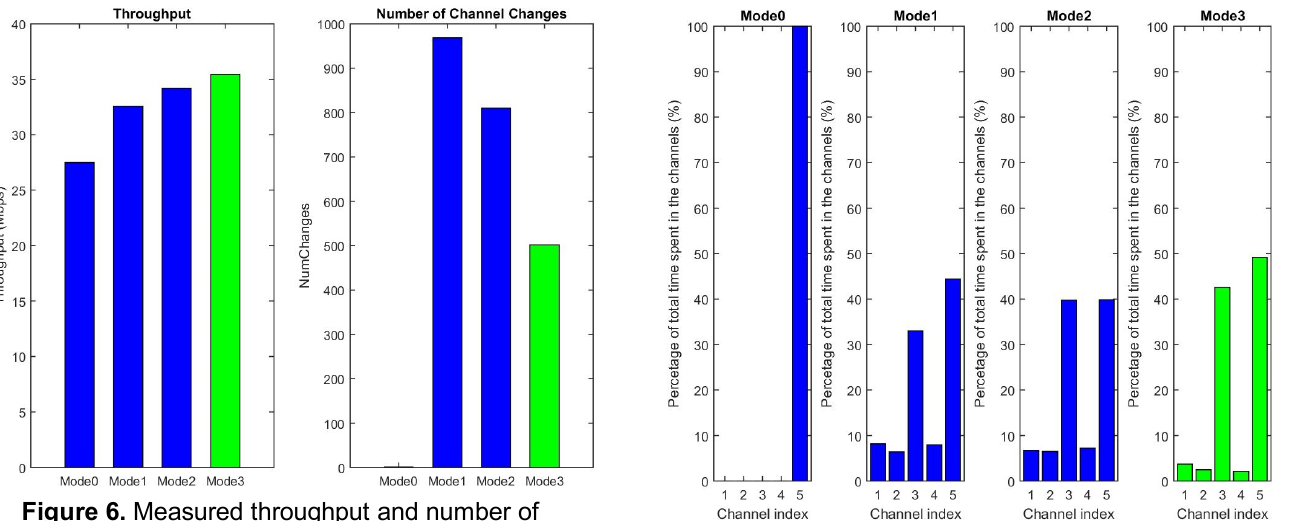
Figure 7. Percentage of time used in channels, random